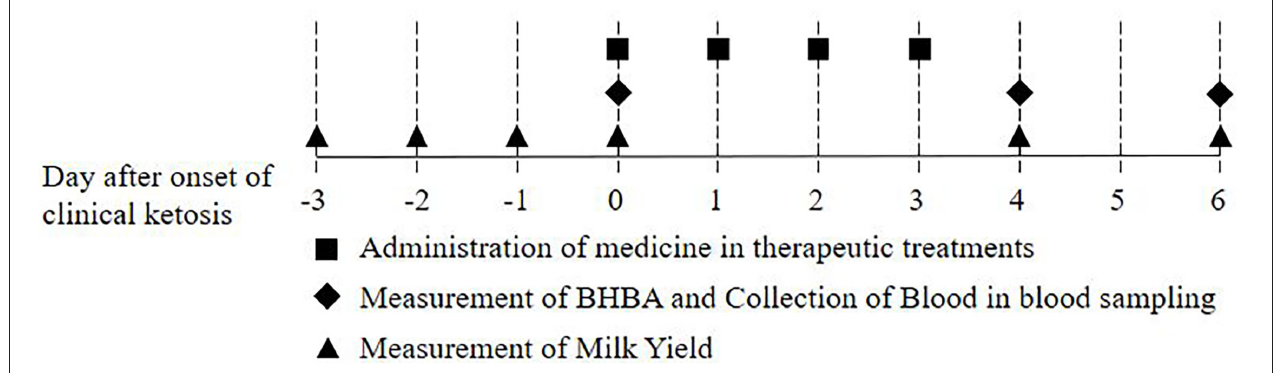
FIGURE 1 | Scheme of this study: Administration of medicine in therapeutic treatments, collection of blood in blood sampling, and measurement of β -hydroxybutyrate (BHBA) and milk yield.